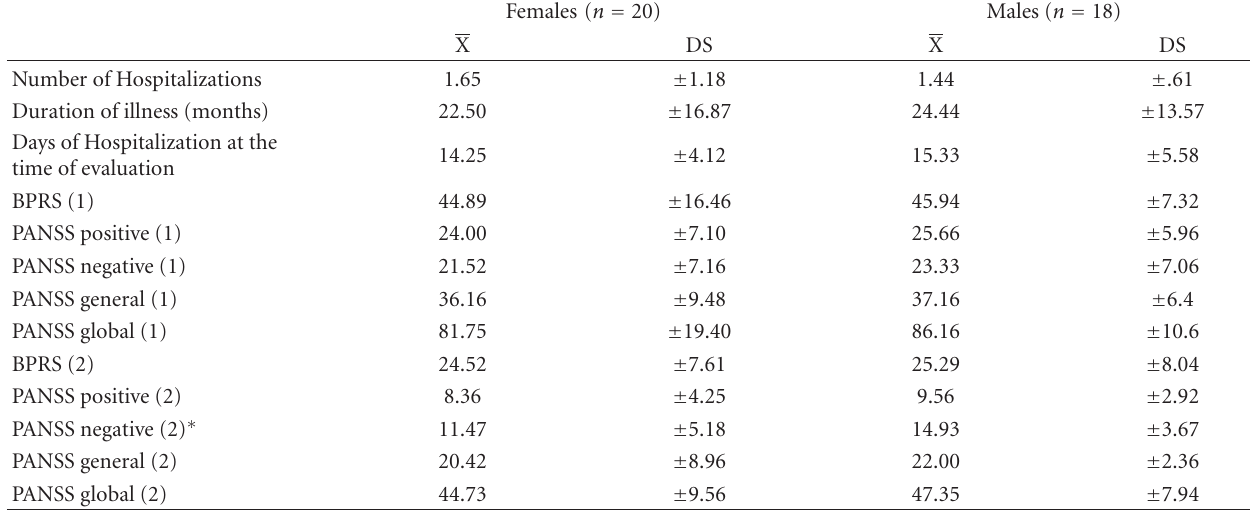
Table 2: Clinical characteristics of the schizophrenic patients; BPRS and PANSS were applied twice, first in the acute phase (1) and later in the remission phase